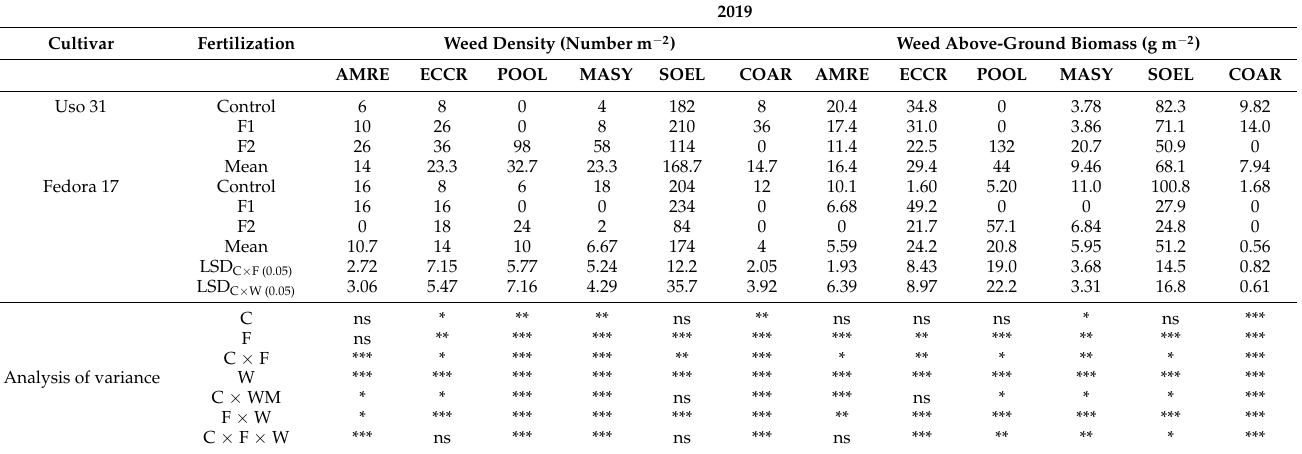
Table 3. The effects of the experimental factors on the average values and the analysis of weed density and weed above-ground dry biomass of weedy plots in the 2019 growing season. AMRE, A. retroflexus , ECCR, E. crus-galli , POOL, P. oleracea , MASY, M. sylvestris , SOEL, S. elaeagnifolium , COAR, C. arvensis